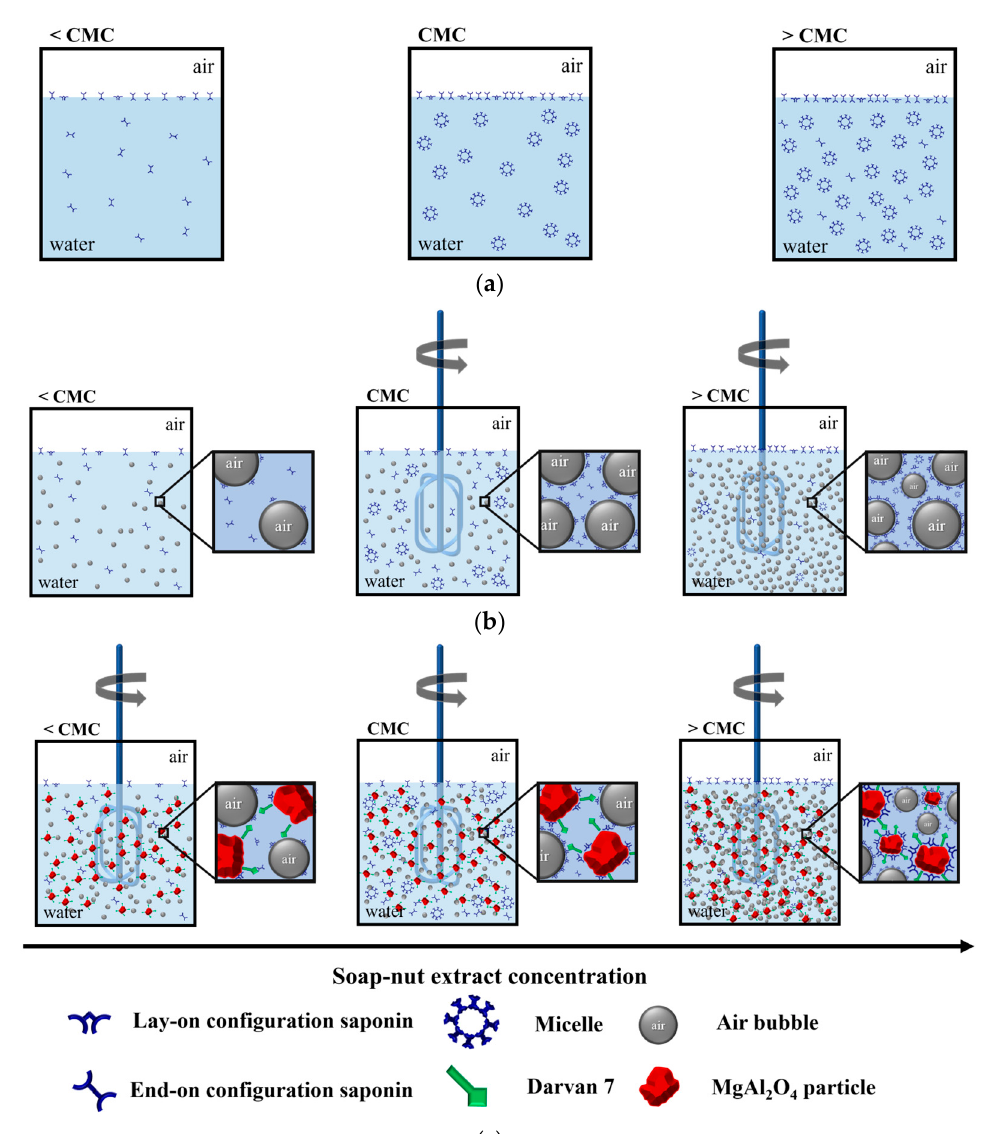
Figure 15. Schematic of the interaction mechanisms of soap-nut extract: ( a ) in water solution, ( b ) during foaming in water, and ( c ) during foaming the ceramic slurry.